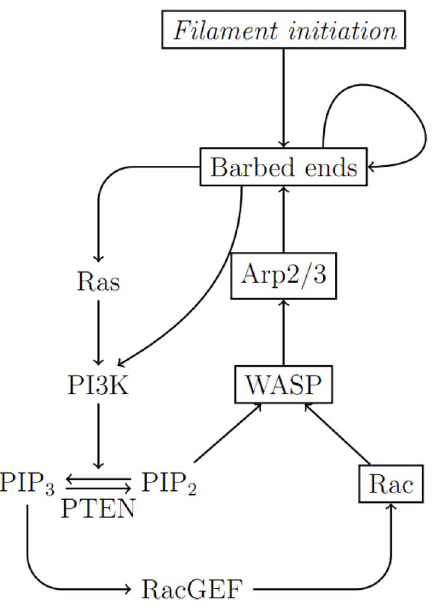
SCAR/WAVE at pseudopods in SCAR/WAVE-null cells. As actin waves also exist in these cells, WASP regulated branching alone is sufficient [21,41].